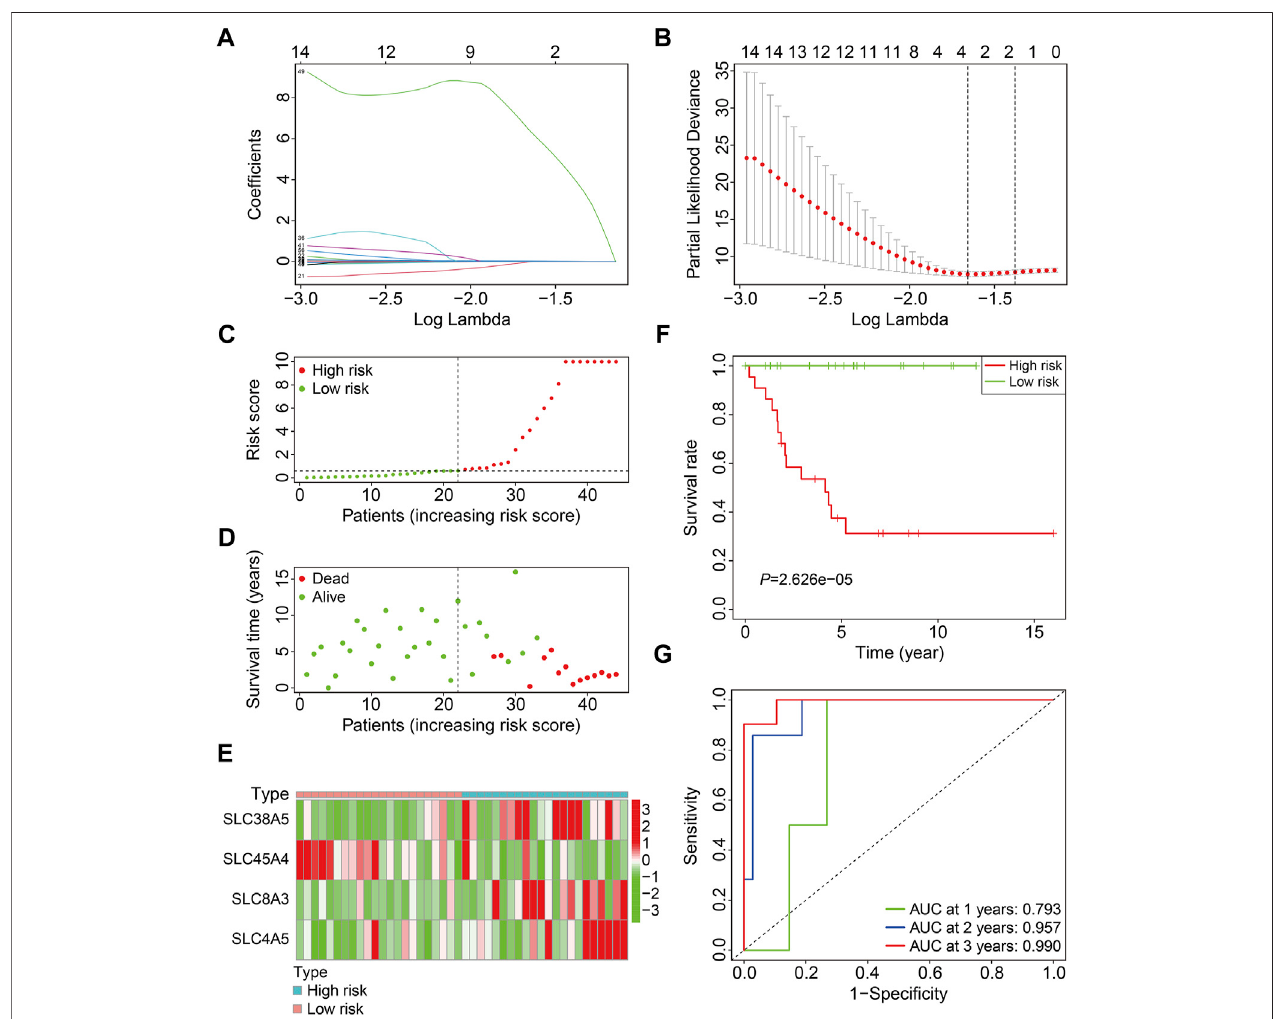
FIGURE2| ConstructionofaSLCfamilygene-basedsignatureinthetrainingcohort. (A) Theregressioncoef fi cientsoftheSLCgenesforthedifferentvaluesofthe penalty parameter (lambda) in the Lasso regression analysis. (B) The 10-fold cross-validation method is used to select the penalty parameter (lambda). The dashed line represents two lambda that produced automatically in the Lasso analysis, one that minimizes the binomial deviance and the other one representing largest λ that is still within1standarderroroftheminimumbinomialdeviance. (C) Distributionofpatients ’ riskscoreintrainingcohort.Thehorizontaldashedlinerepresentsthemedian riskscore.Theverticaldashed lineisthedividinglinethatseparates patientsintohigh-and low-riskgroups. (D) Distribution ofsurvivalstatusandsurvivaltimeofpatients in training cohort. (E) The expression pro fi le of the four SLC genes in training cohort. (F) Kaplan-Meier survival curves. (G) Time-dependent receiver operating characteristic